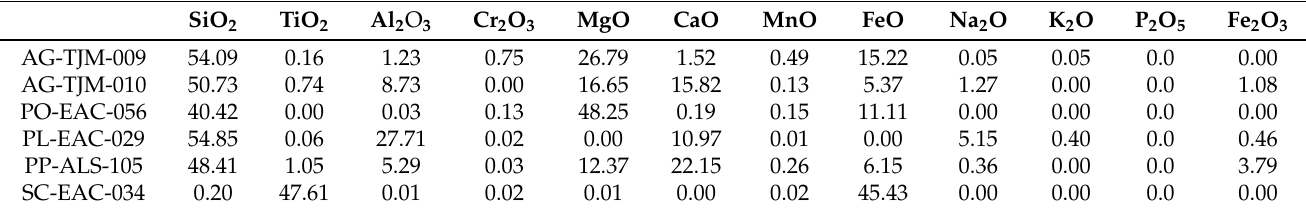
Table A1. Elemental abundances of endmember catalog for experiments in Sections 3.1 and 3.3. The sample spectra and elemental abundances are taken from the RELAB library (https://pds-geosciences.wustl.edu/spectrallibrary/default.htm,